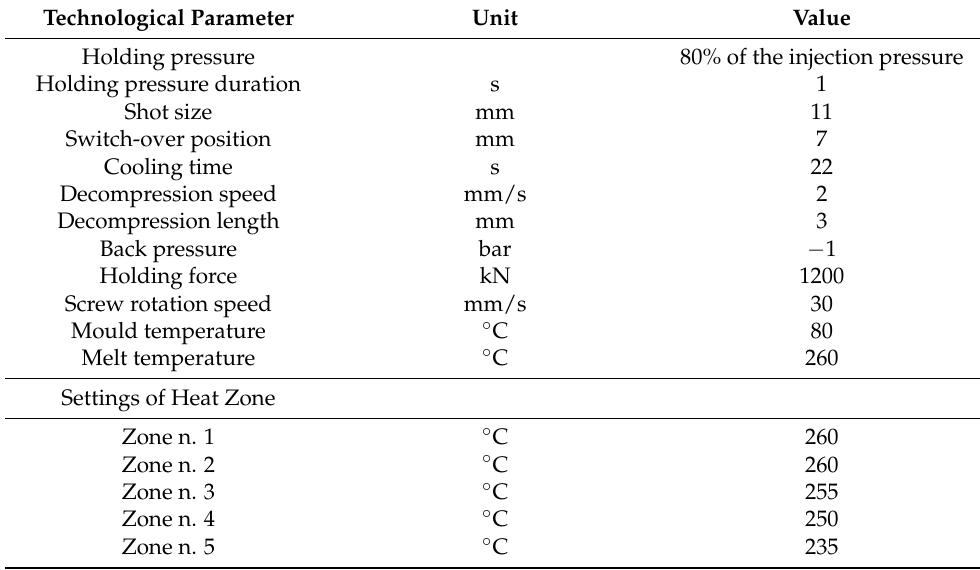
Table A1. Technological parameters settings for individual materials.